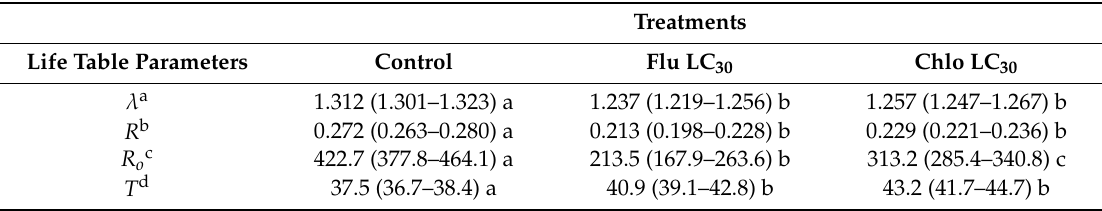
Table 6. Life table parameters for C. virescens (mean, 95% CI) exposed to sublethal concentrations of flubendiamide (Flu) and chlorantraniliprole (Chlo) under controlled laboratory environmental conditions (25 ± 2 °C, 60 ± 10% RH, and 14L: 10D).